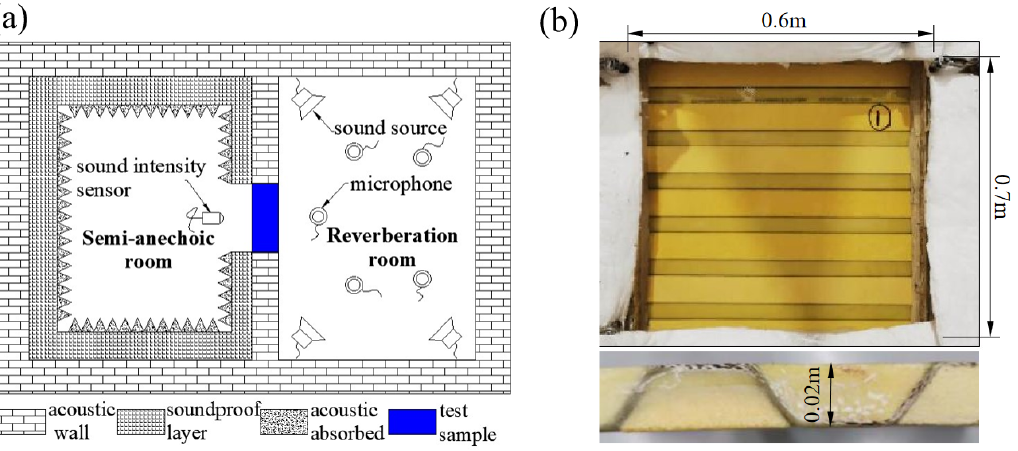
Figure 3. ( a ) Schematic diagram of sound insulation measurement by sound intensity tests. ( b ) The size of the tested composite panel.